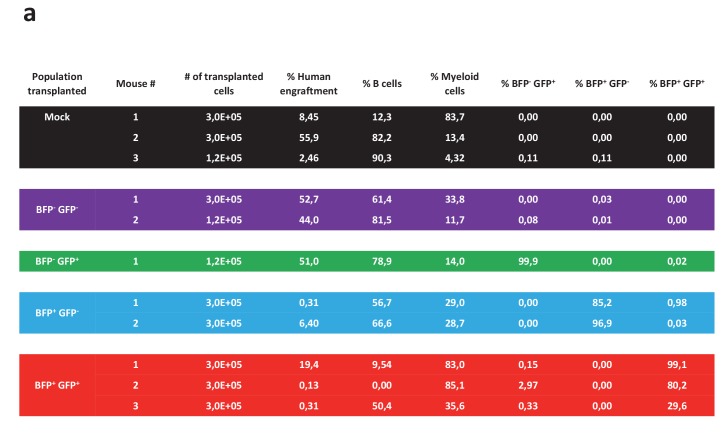
Analysis of mice transplanted with different sorted populations of cells targeted at the HBB and AAVS1 locus.The table shows an overview of the 11 NSG mice that were transplanted intrafemorally with either mock-electroporated cells or sorted cells from the four populations displayed in Figure 3f. 12 weeks after transplant, the transplanted femurs were flushed and the cells analyzed for human engraftment based on HLA-ABC expression, B cell or myeloid phenotype (CD19 and CD33, respectively), and expression of the two reporter genes.